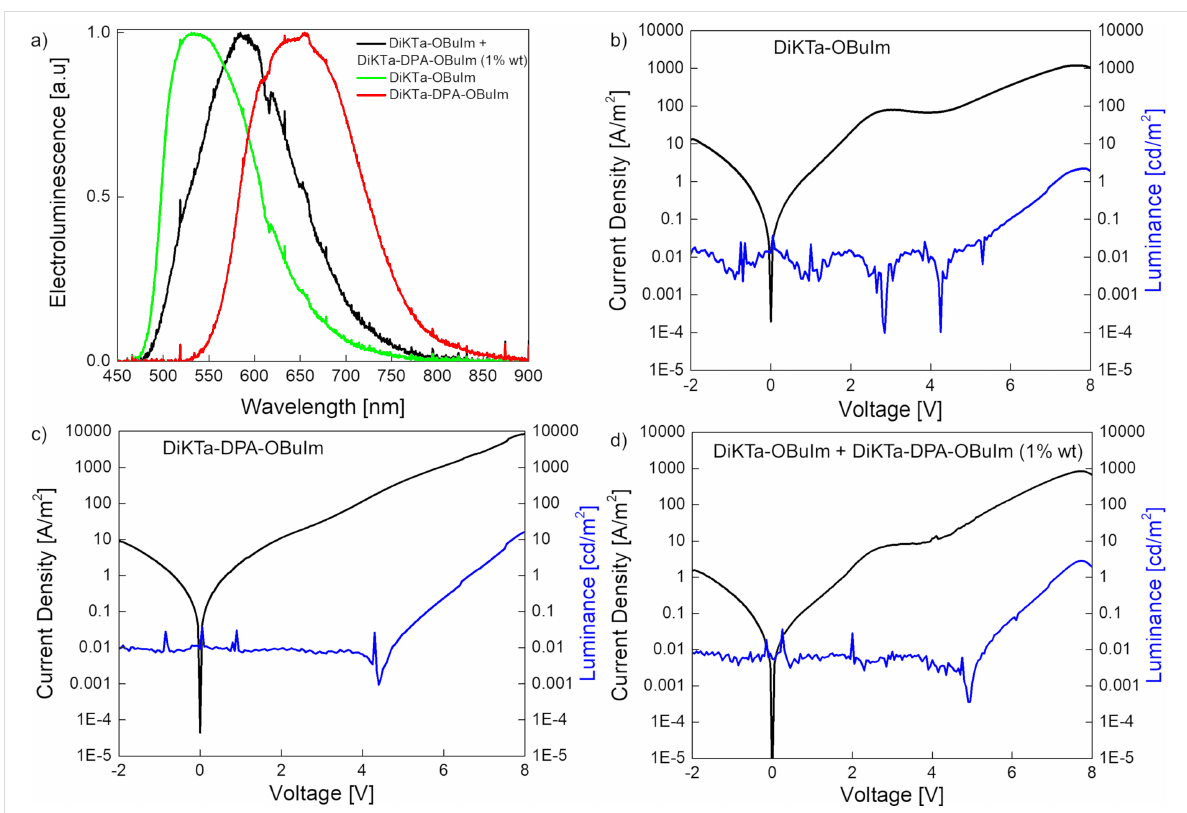
Figure 5: (a) Electroluminescence spectra of DiKTa-OBuIm (green curve), DiKTa-DPA-OBuIm (red curve) and 1% of DiKTa-DPA-OBuIm in DiKTa- OBuIm (black curve). Current (black) and luminance (blue) versus voltage ( JVL ) sweep (from − 2 to 8 V) of (b) DiKTa-OBuIm , (c) DiKTa-DPA- OBuIm , and (d) 1% of DiKTa-DPA-OBuIm in DiKTa-OBuIm